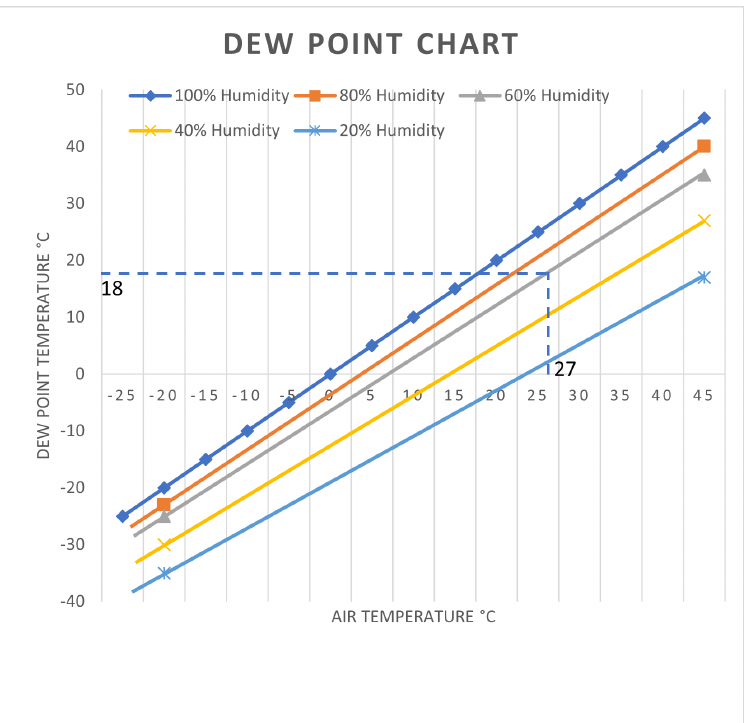
Figure 3. Relationship of air temperature, dew point and humidity for elevations of 0 to 1524 m (adapted from